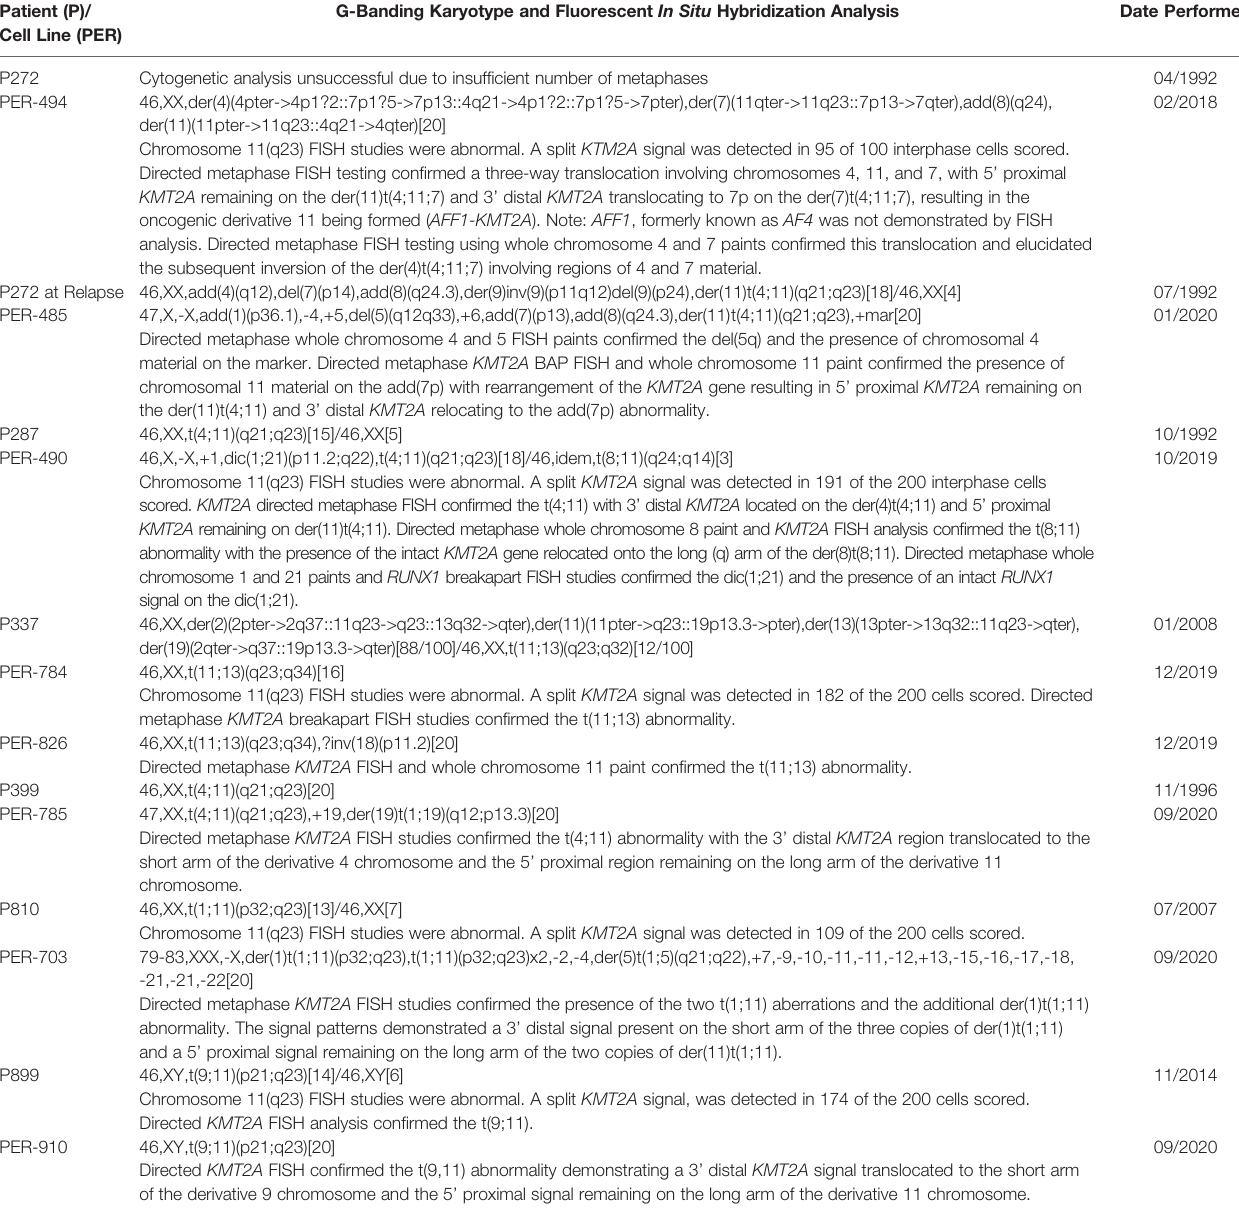
TABLE 3 | Cytogenetic analysis of primary patient samples and corresponding cell lines. Patient (P)/ G-Banding Karyotype and Fluorescent In Situ Hybridization Cell Line (PER)